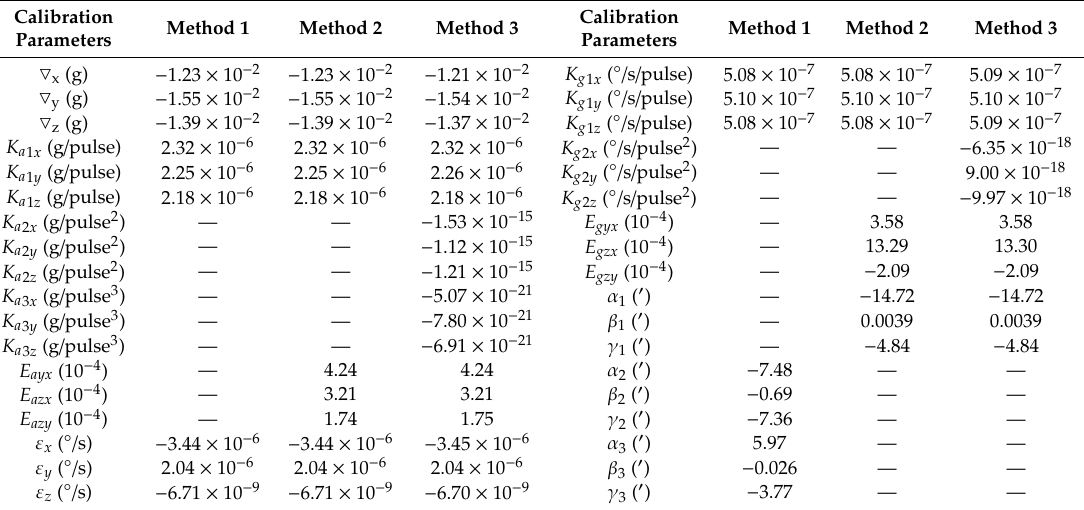
Table 4. The calibration results of